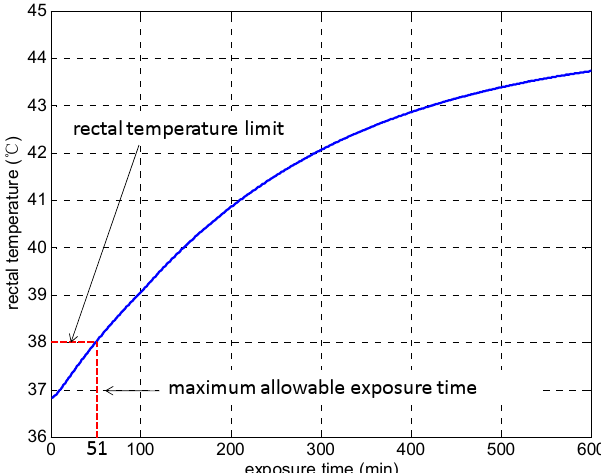
Figure 2. Variation of rectal temperature with exposure time.